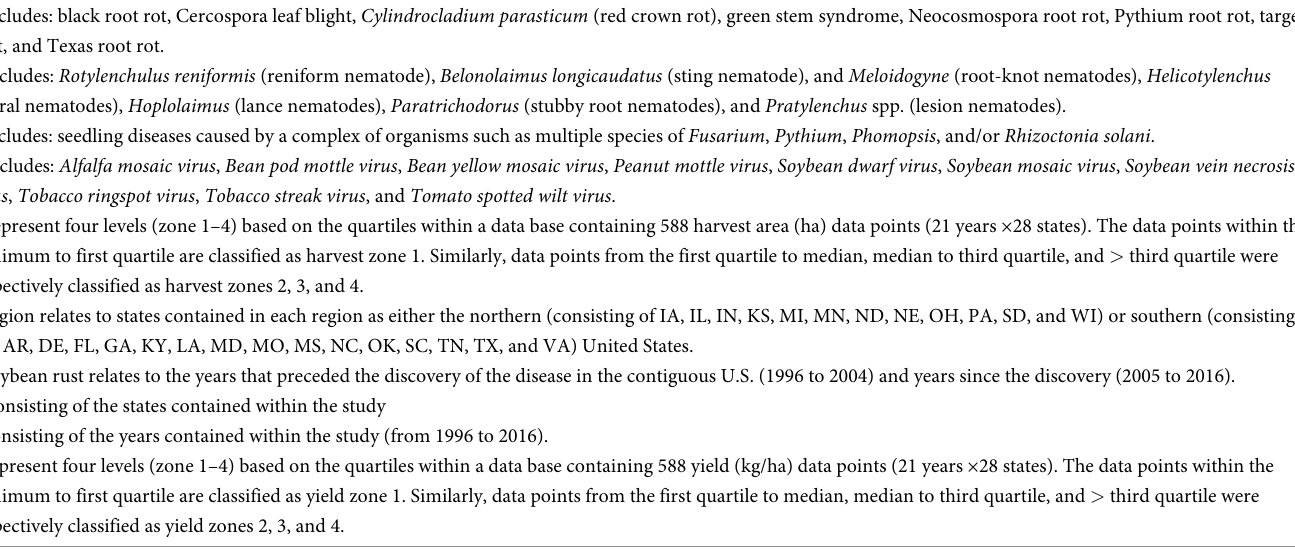
Table 2. Percent contribution of variables to the first five principle components (dimensions = dim.) as revealed via principle component analysis (PCA) and factor analysis with mixed data (FAMD) approaches. Variable